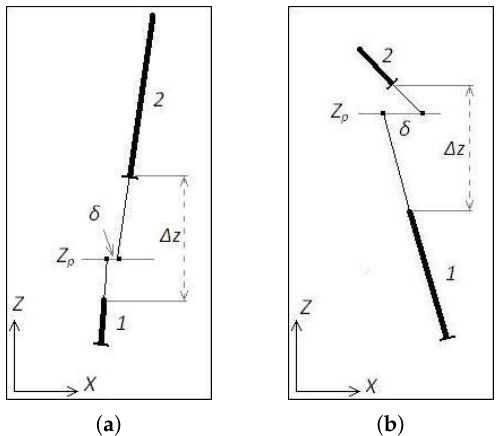
Figure 13. Connection test of fragments: ( a ) Connection established ( δ ≤ δ min ); ( b ) Connection not established ( δ > δ min ).